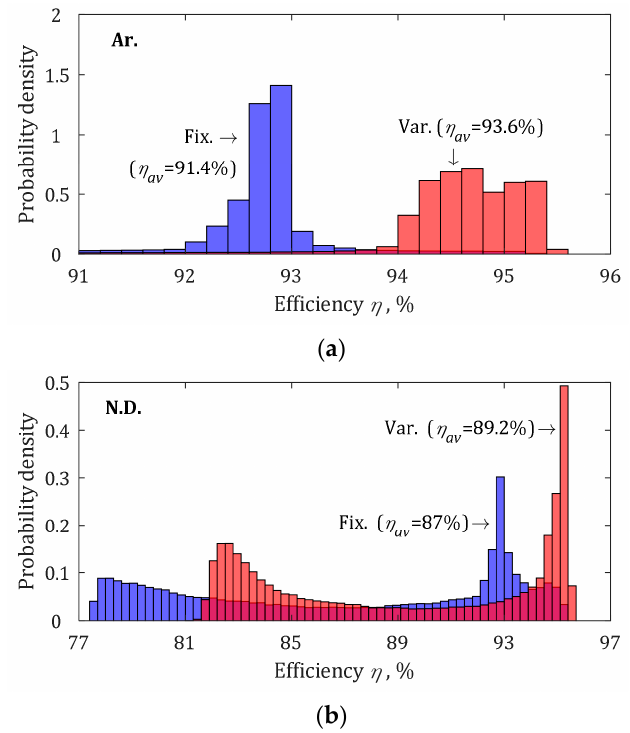
Figure 15. Density distribution of the microinverter and average efficiencies for two dc-link voltage control methods for Arizona ( a ) and North Denmark ( b ) geographic locations.